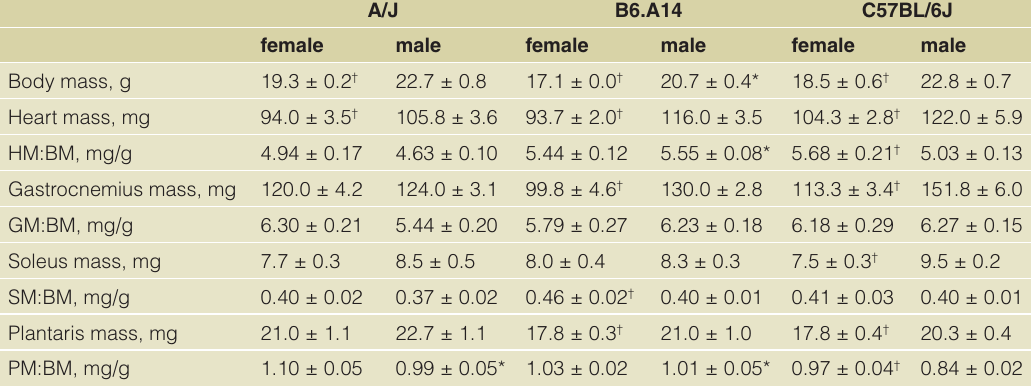
Table 2. Exercise capacity and physical characteristics of female and male (B6.A14 × B6) F